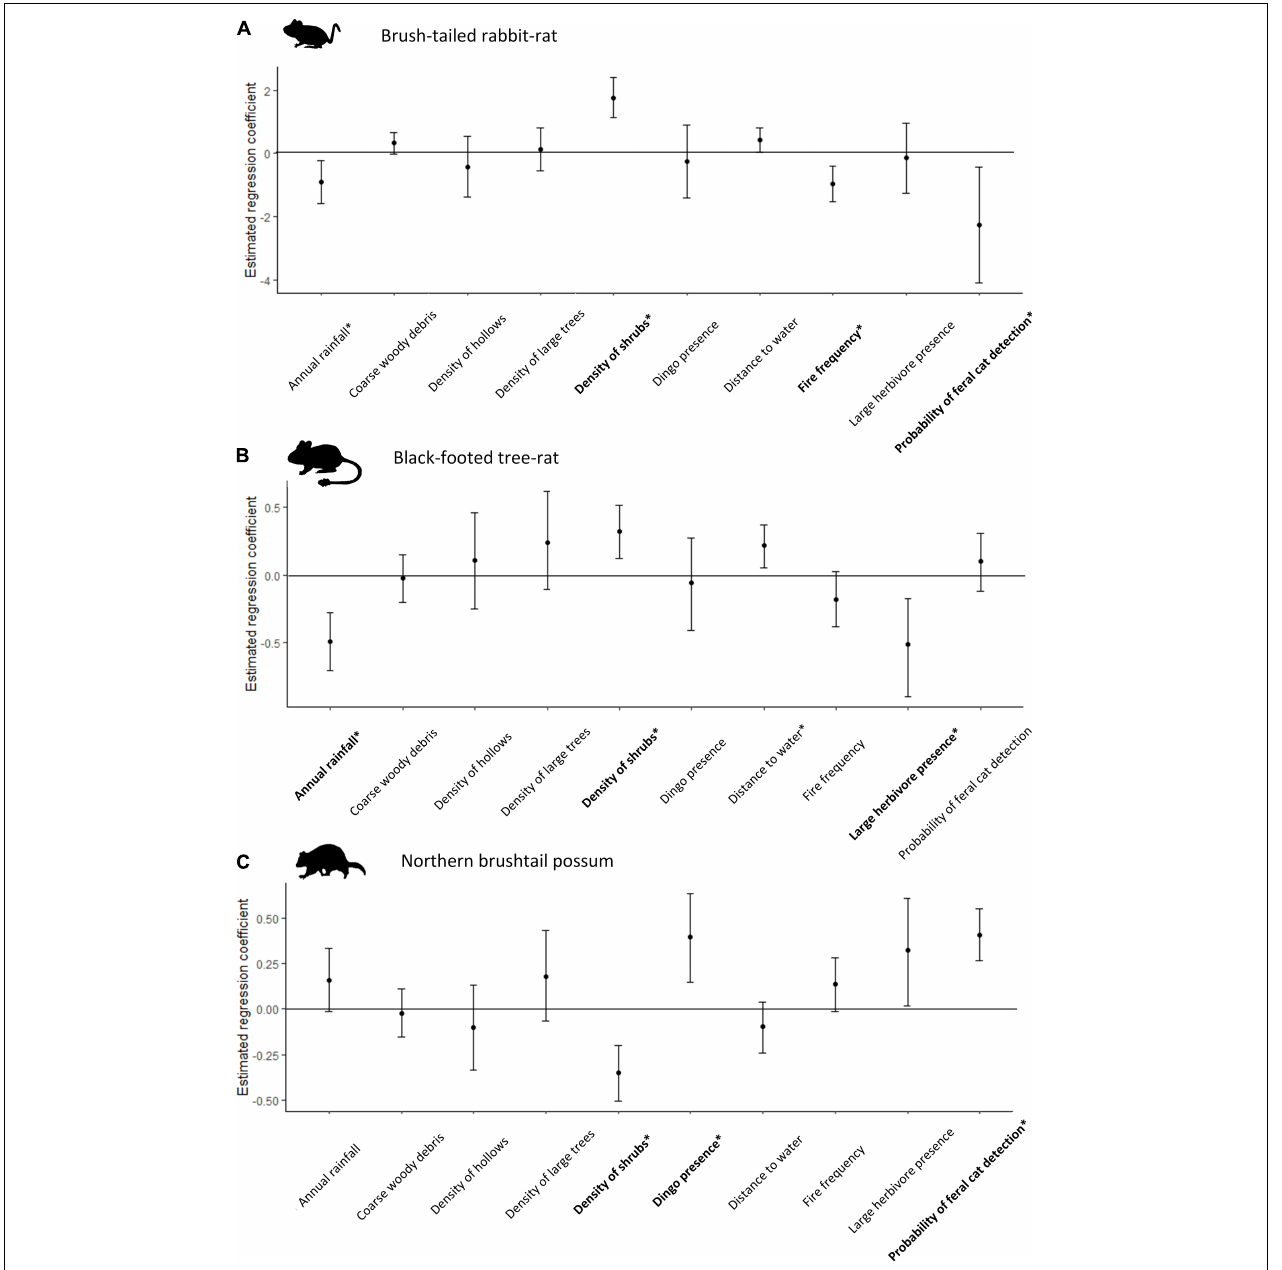
FIGURE 2 | Coefficient estimates for (A) brush-tailed rabbit-rat; (B) black-footed tree-rat; and (C) northern brushtail possum from the global model. Error bars indicate 95% confidence intervals; asterisks indicate where they do not overlap zero, i.e., a statistically significant effect and covariates in bold are for which there was clear evidence of a relationship from the Royle–Nichols models ( Table 2